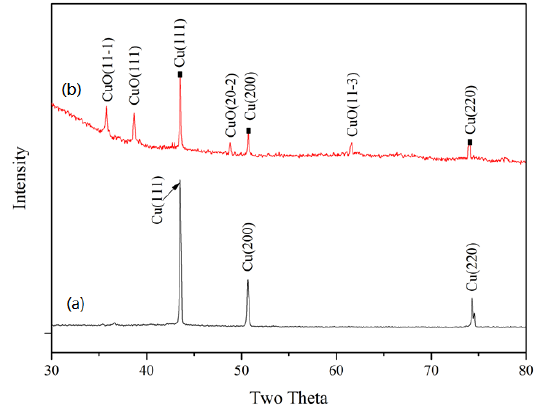
Figure 2. XRD patterns of (a) CuNWE and (b) CuO/CuNWE.